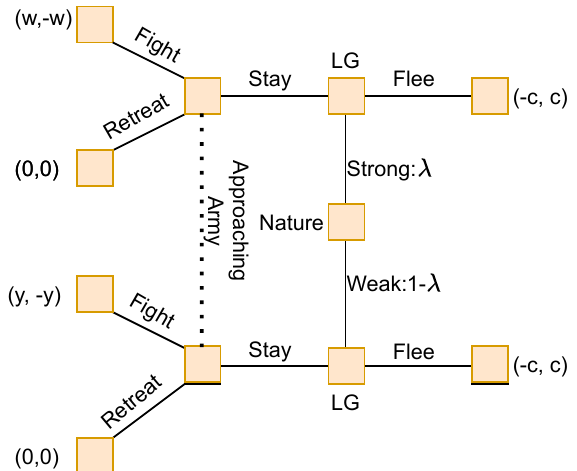
Figure 3. The Empty City signaling game [68] In Figure 3